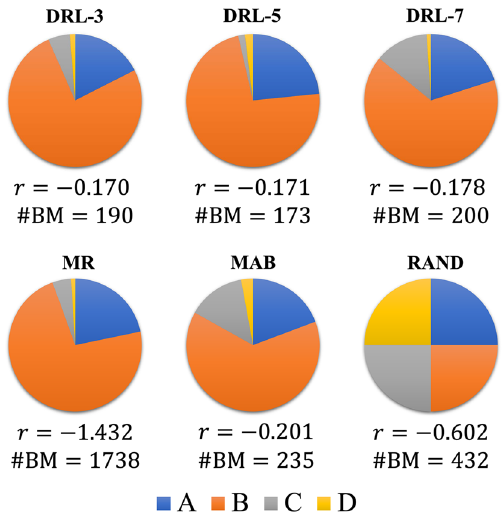
Fig. 11 Distribution of action selections for different beam training policies for